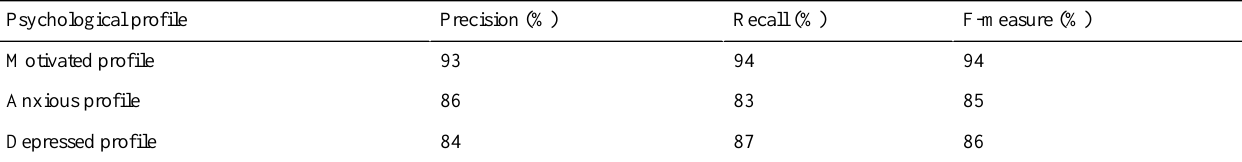
Table 4. Precision, recall, and F-measures of the psychological profile detection.